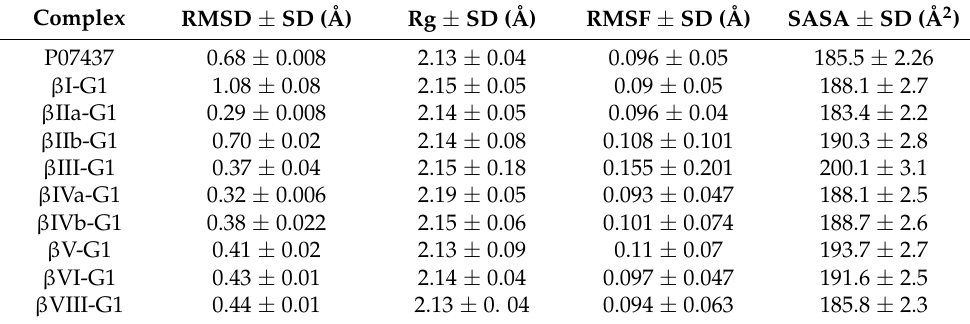
Table 5. The average of RMSD, RMSF, Rg, and SASA for nine distinct β -tubulin isotypes during the last 20 ns of MD